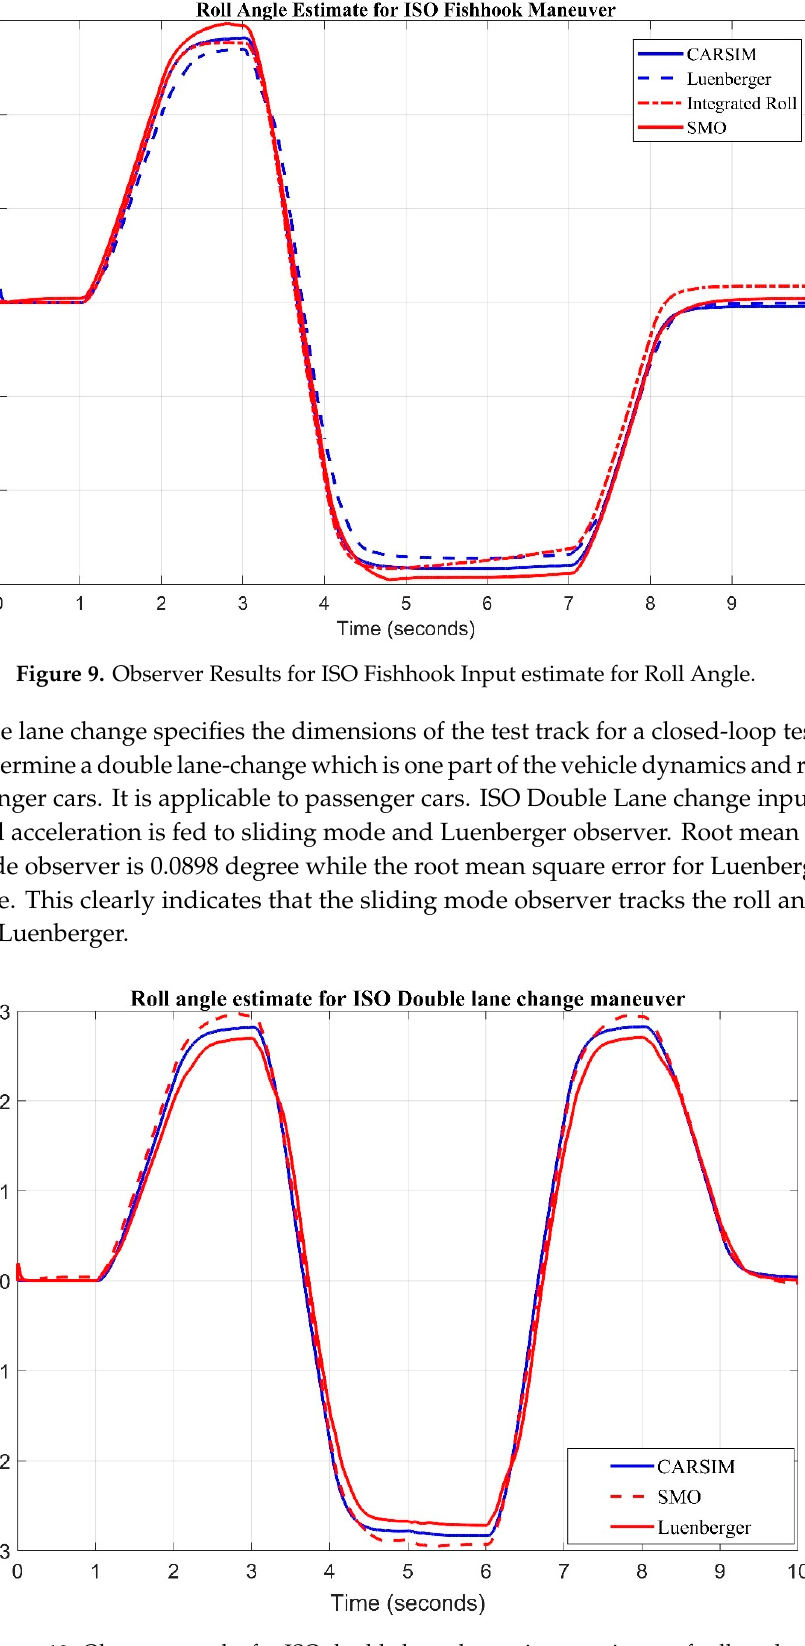
Figure 10. Observer results for ISO double lane change input estimate of roll angle .